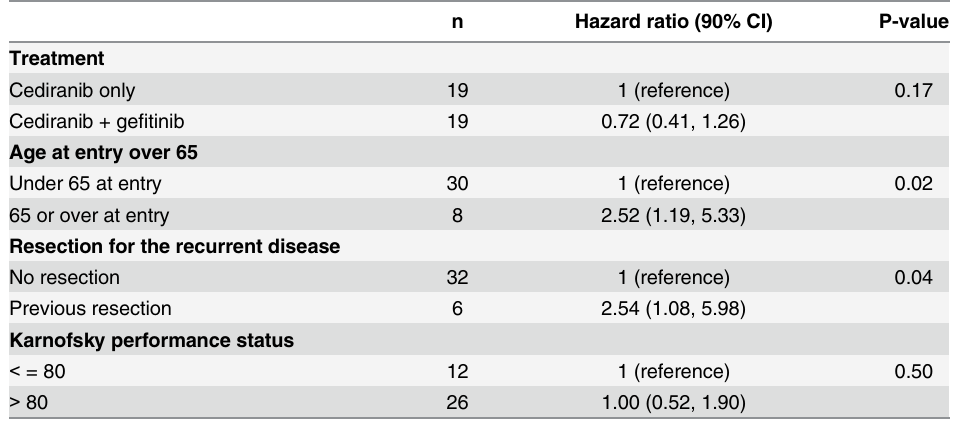
Table 2. Cox regression model for